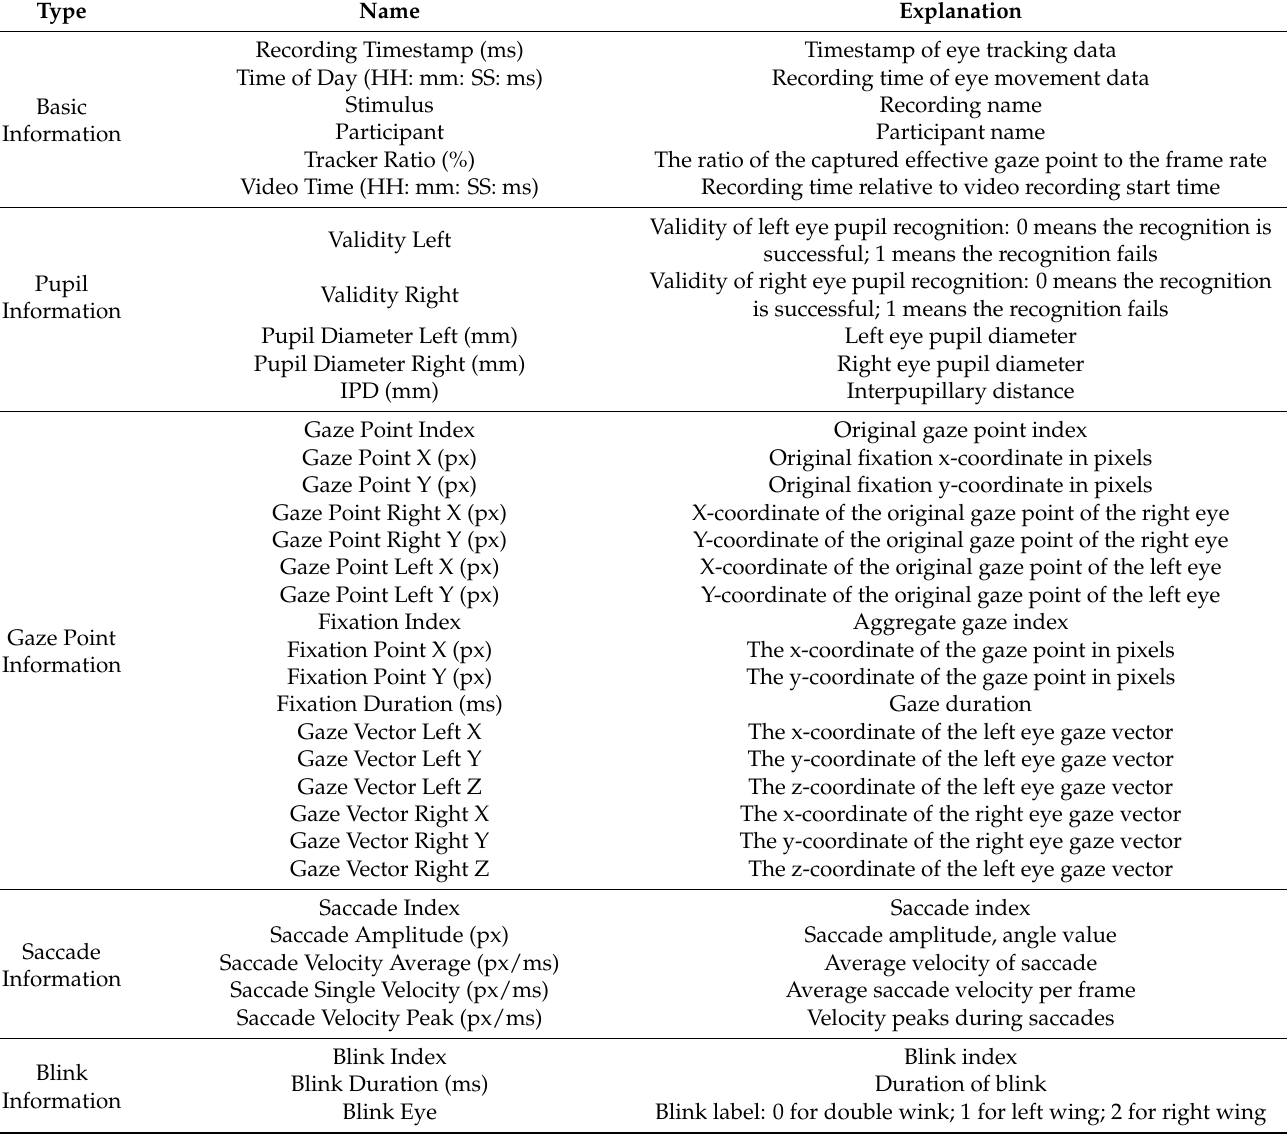
Table 2. Eye tracker acquisition parameters and their